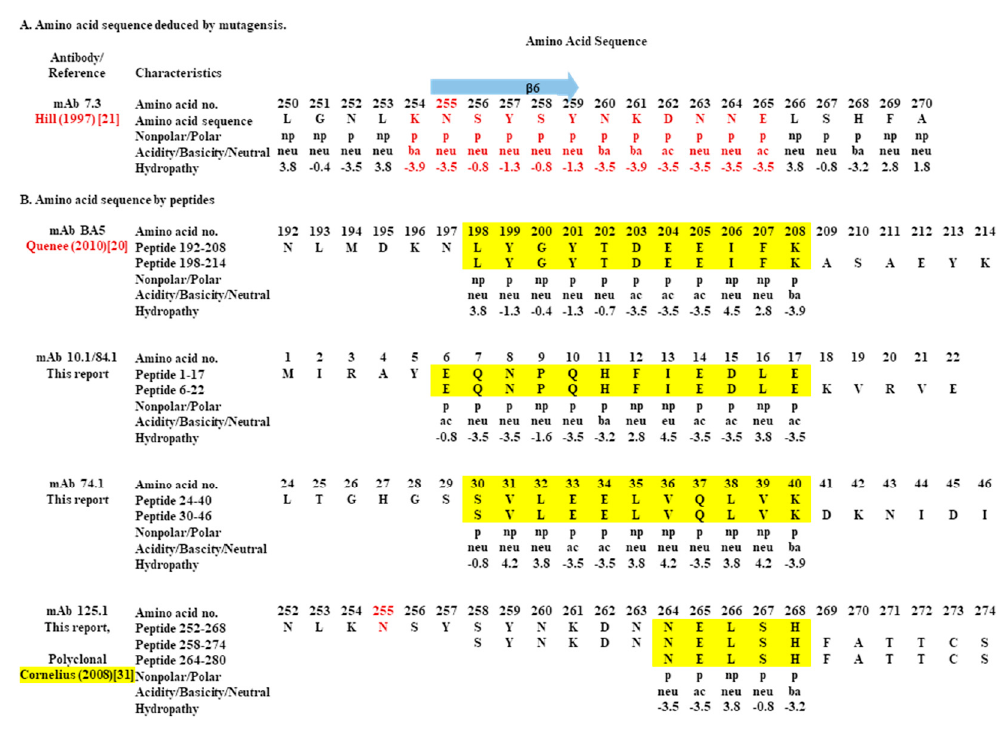
Figure 5. Summary of amino acids in putative binding sites in the V-antigen derived from mutagenesis or mAbs binding to linear peptides. ( A ). Region of binding of mAb 7.3 derived from mutational analysis identified N255 as a critical amino acid [21]. The region from amino acid 250 to 270 is shown with N255 in red and the beta-sheet β 6 shown above. Also listed in red are amino acids 254–265 that includes N255, and polarity (nonpolar, np / polar, p), acidity (ac) / basicity (ba) / neutrality (neu), and hydropathy index. Note 12 contiguous negative hydropathic amino acids. ( B ). Region of common overlapping V-antigen peptides identified by binding by mAbs (in yellow). Listed are mAbs BA5 [20] (11 amino acids), 10.1 / 84.1 (12 amino acids), 74.1 (11 amino acids), and 125.1 (5 amino acids). Also listed are the amino acid number, amino acid, polarity (nonpolar, np / polar, p), acidity(ac) / basicity (ba) / neutrality (neu), and hydropathy idex. The amino acids listed for mAb 125.1 were also identified by another study with polyclonal antibodies from nonhuman primates and BALB / c mice raised against V-antigen [31]. N255 within this region was highlighted in red. The peptide 264–280 amino acids that was recognized by 125.1 was shortened (275–280 amino acids) for presentational purposes in the figure.